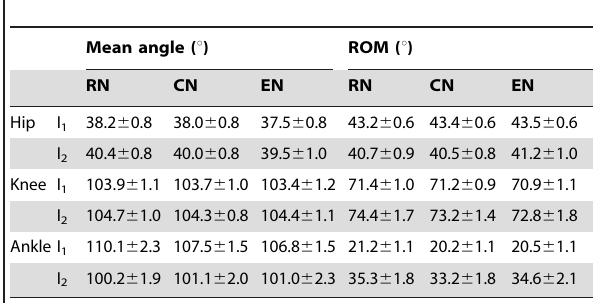
Table 3. Kinematic variables: Mean angle and ROM (mean 6 SEM) of the hip, knee and ankle angles measured throughout the complete crank cycle during interval 1 (I 1 ) and interval 2 (I 2 ) of the Wingate test performed the following morning after 3 different